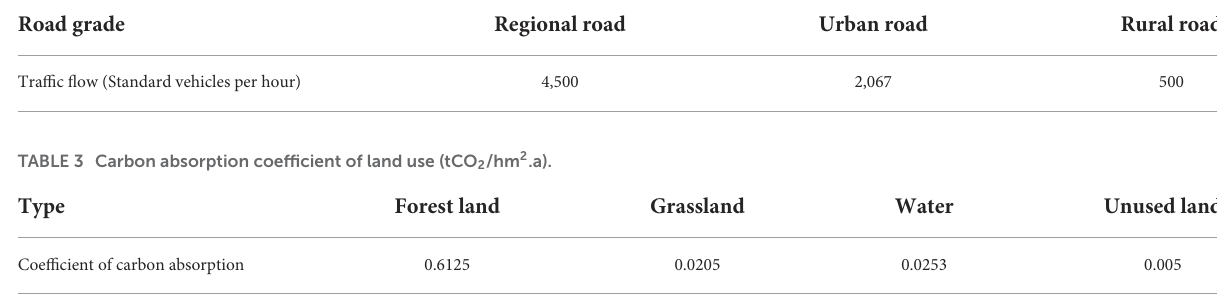
TABLE 2 The reference value of the traffic flow of each grade of the road.